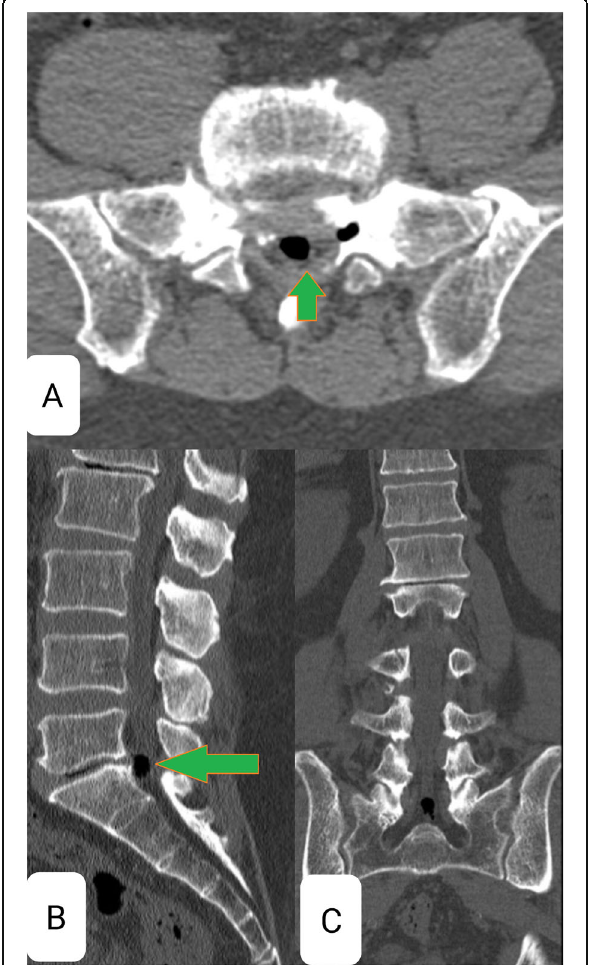
Fig. 1 CT scan. Axial ( a ), sagittal ( b ), and coronal ( c ) CT scan images reveal degenerative changes in the lumbar spine and vacuum phenomenon at L1 – 2 and L5-S1 levels, with facet joint degenerative changes in L5-S1 level. There is an air density seen in the intraspinal region at L5-S1 level. Reduced intervertebral disc space seen at L1-2 and L5-S1 levels. Origin: © Department of Radiology, King Salman Hospital, Riyadh, Kingdom of Saudi Arabia,